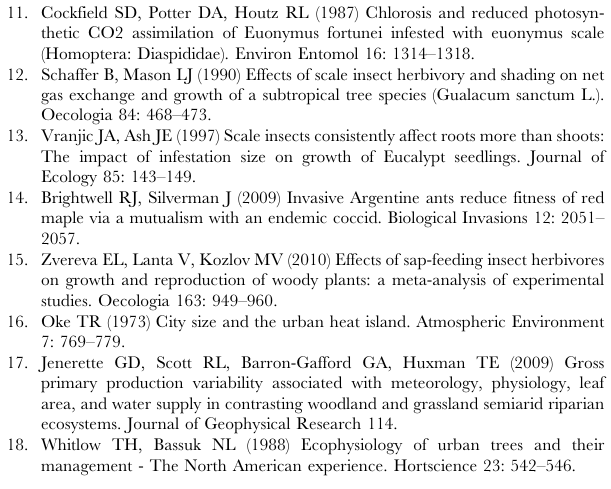
Figure S1 (Left) Red maple heavily infested with M. tenebricosa exhibiting branch dieback and darkened bark. (Right) Red maple branch moderately infested with M. tenebricosa (bumps on bark). (JPG) Table S1 Contingency table comparing tree condition to surface temperature